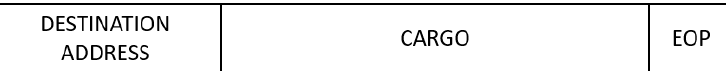
Figure 1. SpaceWire (SpW) packet